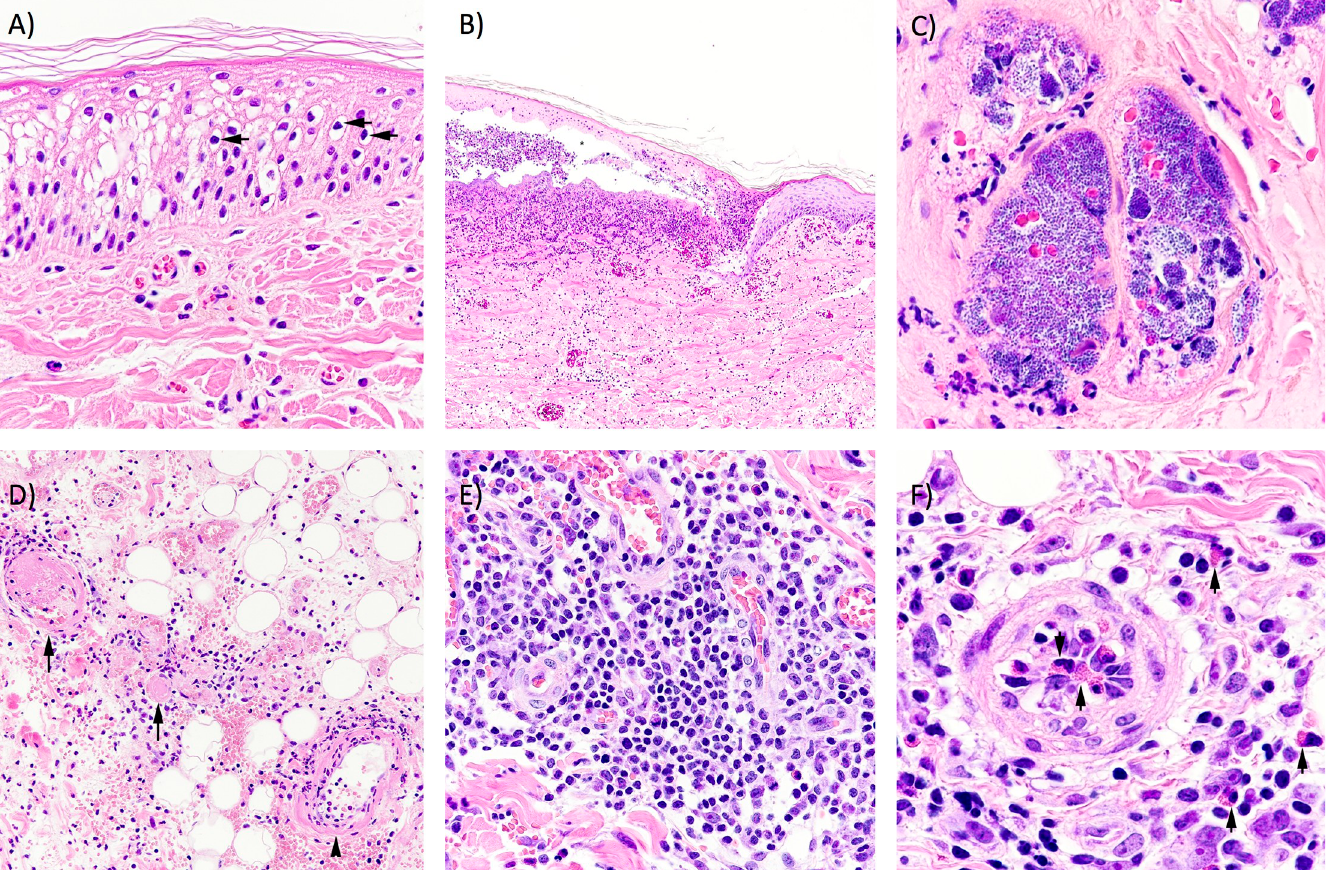
Fig 5. Haemotoxylin and Eosin Stained Histopathology of ear sections from VD and DD hapten treated animals (7 and 21 day sensitization period). A) Skin epidermis from a DD animal (7 day sensitization). Note the vacuolated epidermal cells and shrunken pyknotic nuclei (arrows). B) Skin epidermis from VD animal (7 day sensitization). Note the cleft within epidermal layers ( � ) containing neutrophils and fibrin. Basal epidermal layers and superficial dermis contain numerous inflammatory cells. C) Skin from DD animal (7 day sensitization) vessels within epidermis contain numerous basophilic coccobacilli. D) Subcutis skin from DD animal (21 day sensitization). Note the vessels containing fibrin thrombi (arrows), and vasculitis and fibrinoid degeneration (arrowhead). E) Dermis skin from DD animal (21 day sensitization). Vessels are surrounded by numerous inflammatory cells, mostly lymphocytes. F) Dermis skin from DD animal (7 day sensitization). Granulocytes are evident within perivascular infiltrate as well as within